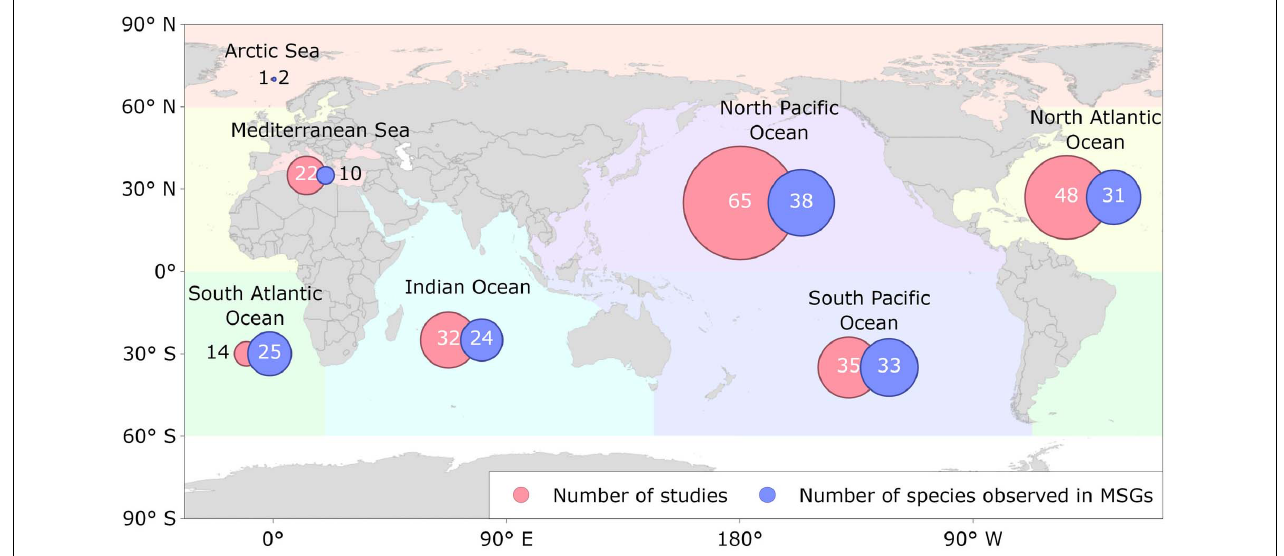
FIGURE 5 | Geographical distribution of the location of the studies reviewed that reported cetacean mixed-species groups (MSGs) across the major ocean basins from 1961 to 2020. Numbers inside circles represent the number of reviewed studies reporting the occurrence of cetacean MSGs in each ocean basin and the number of cetacean species observed in those